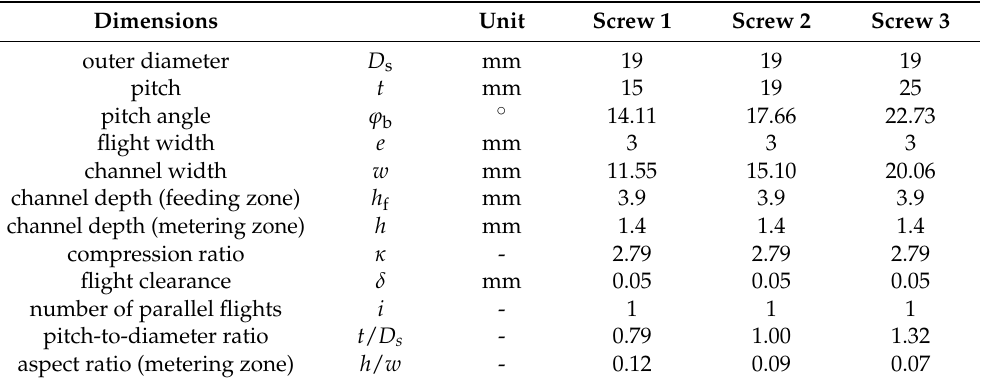
Figure 3. Schematic diagram of the extruder screws. Table 5. Dimensions of extruder screws.